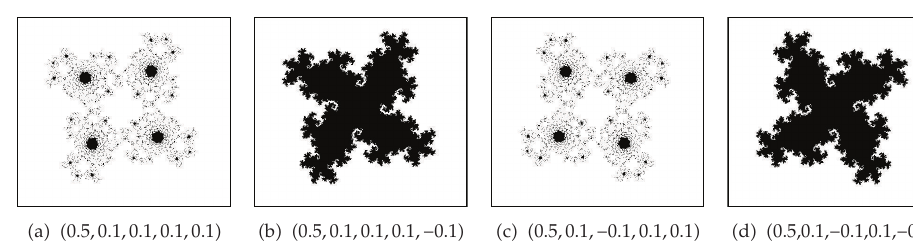
Figure 17: The generalized J sets perturbed by the composing noise when α (cid:6) 4, here Figures (cid:3) a (cid:4) and (cid:3) b (cid:4) are the graphs with c (cid:6) 0 . 5 (cid:5) 0 . 5 i , Figures (cid:3) c (cid:4) and (cid:3) d (cid:4) are the graphs with c (cid:6) 0 . 5 − 0 . 5 i .